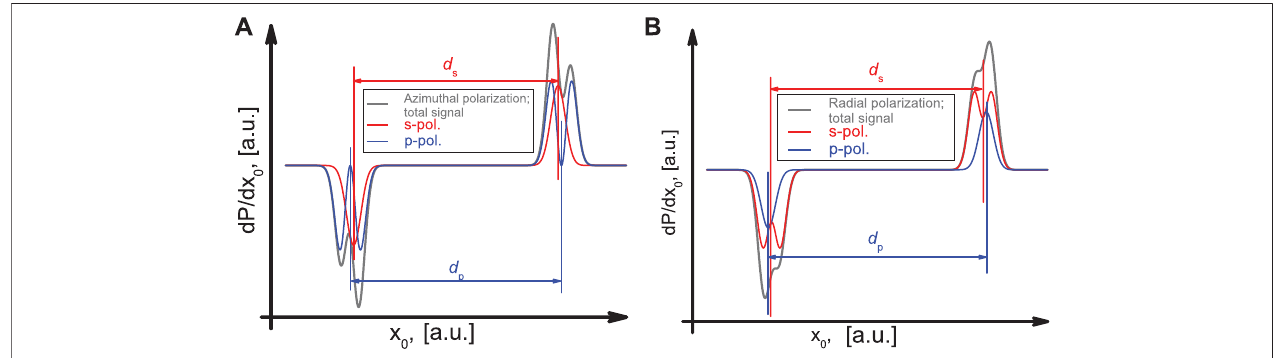
Frontiers in Physics |